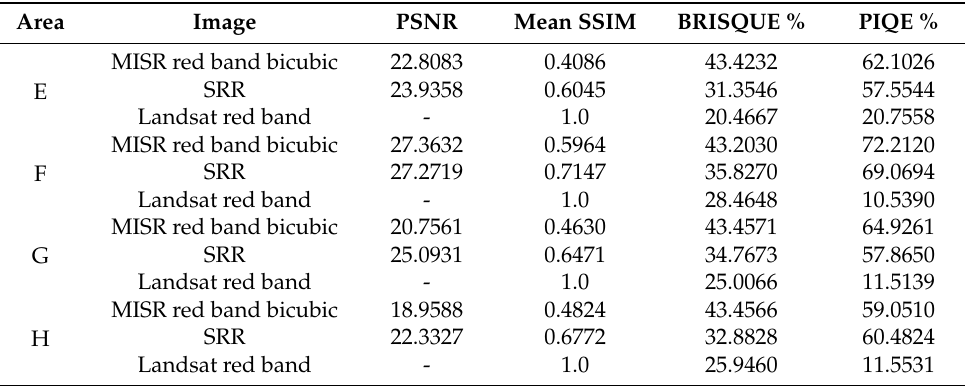
Table 2. Statistics of the image quality metrics for the bicubic interpolated MISR red band input reference image, SRR results, and the Landsat 7 red band validation reference image for the 4 areas in the second testing